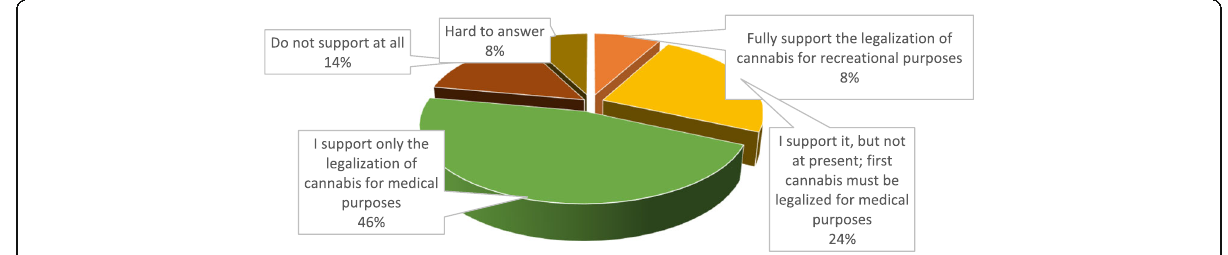
Fig. 6 Ukrainian pharmacy students ’ attitude to legalization of cannabis and cannabinoids for recreational purposes in